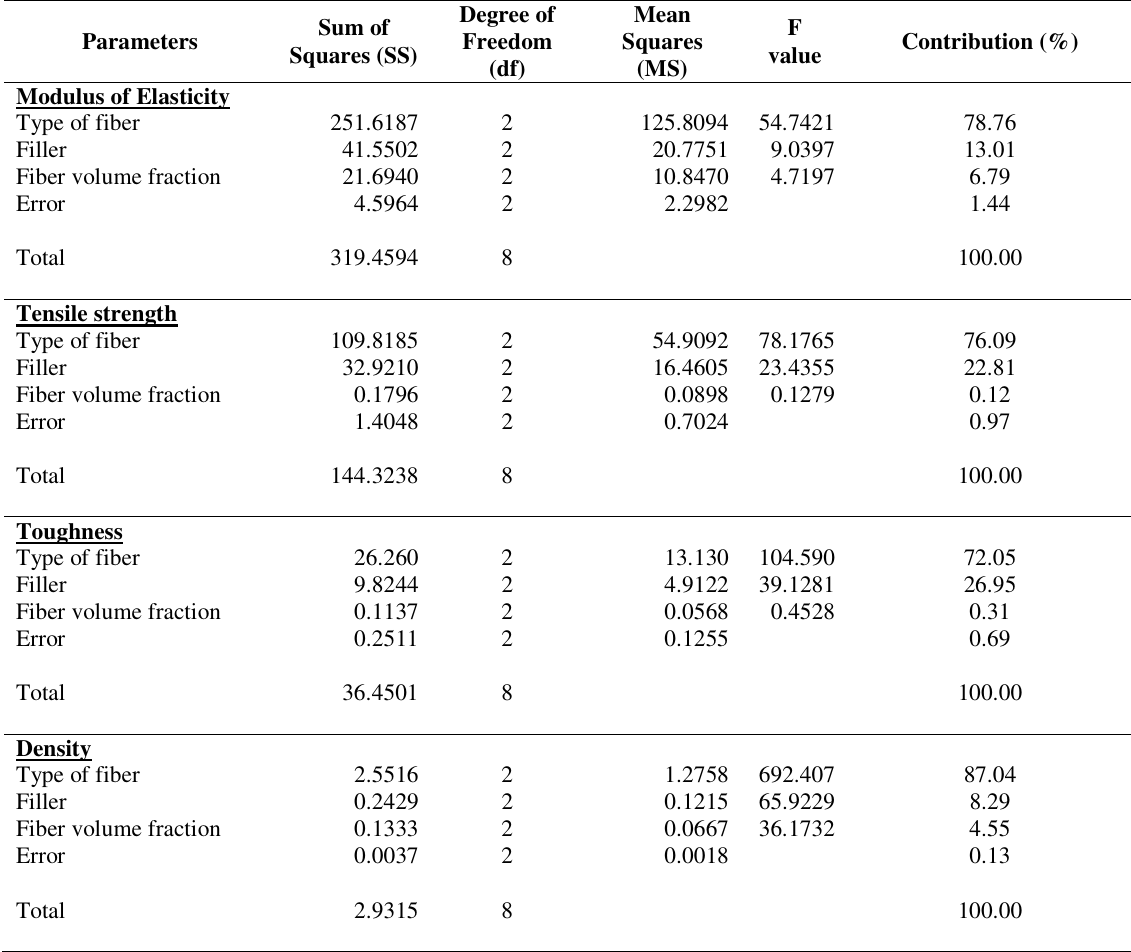
Degree of Freedom